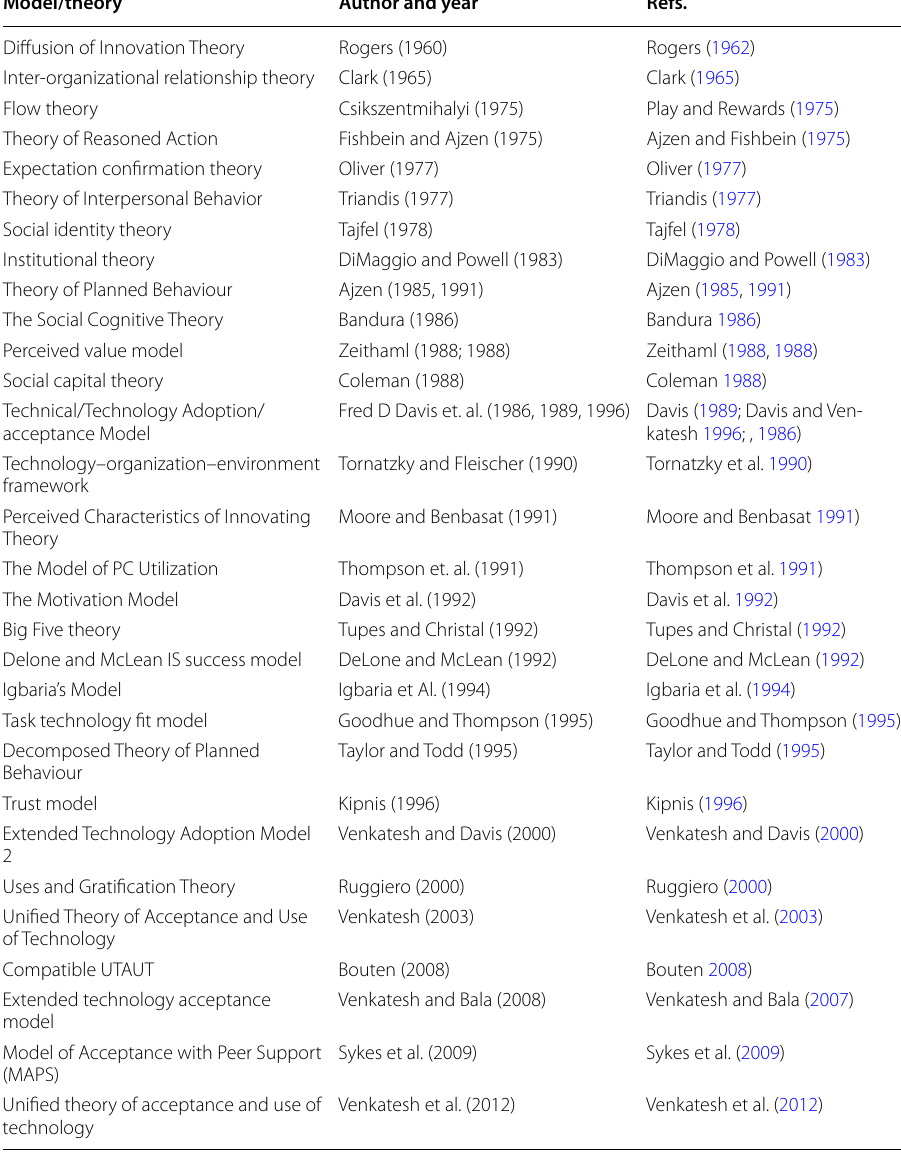
Table 8 Technology adoption theories in the literature Model/theory Author and year